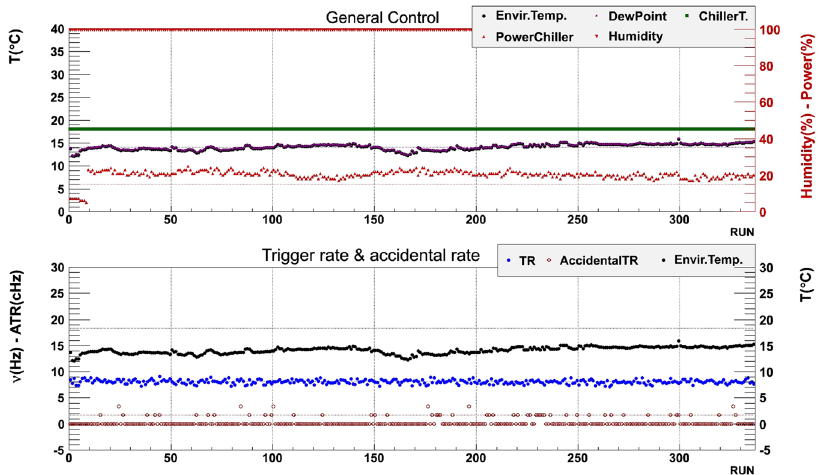
Figure 7. Stability of the main parameters that monitor the status of the detector during the Mt. Echia data tacking. Top: Environmental temperature, dew point temperature, chiller temperature and power, relative humidity. Bottom: Trigger rate, accidental rates, environmental temperature. The drawing was obtained using the software root